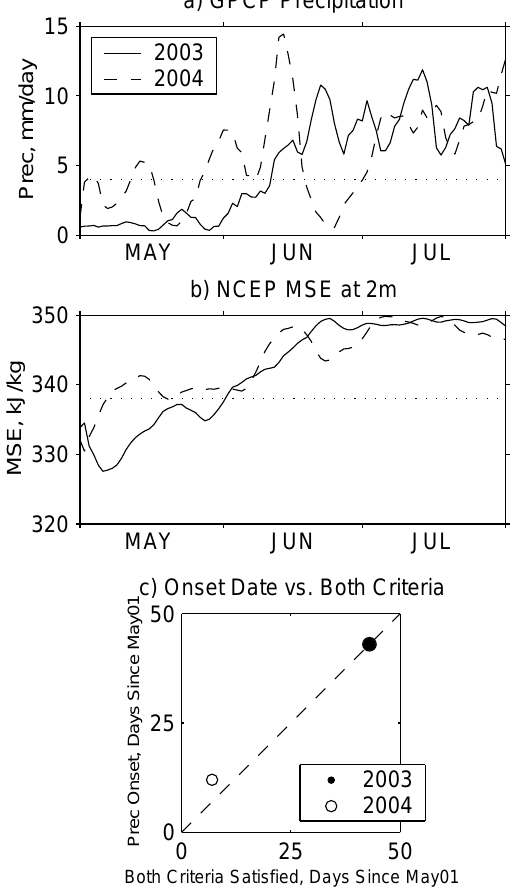
Fig. 23. Precipitation onset date vs. moist static energy and ver- tical velocity criteria for the onset in observation-based data over the region 70 ◦ –90 ◦ E, 5 ◦ –25 ◦ N (land part) during 2003 and 2004 (all-India onset was substantially delayed in 2003 as compared to 2004.) (a) time series of GPCP (Huffman et al., 2001) precipita- tion. (b) time series of moist static energy at 2m. (c) onset date vs. the day when both the criteria were